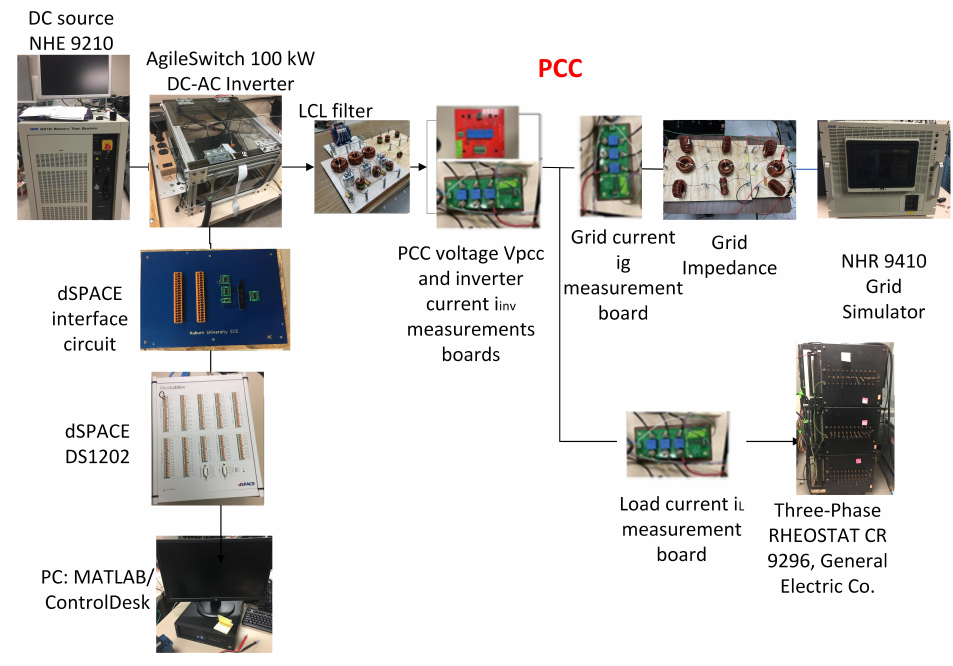
Figure 11. Block diagram for the testbed system.